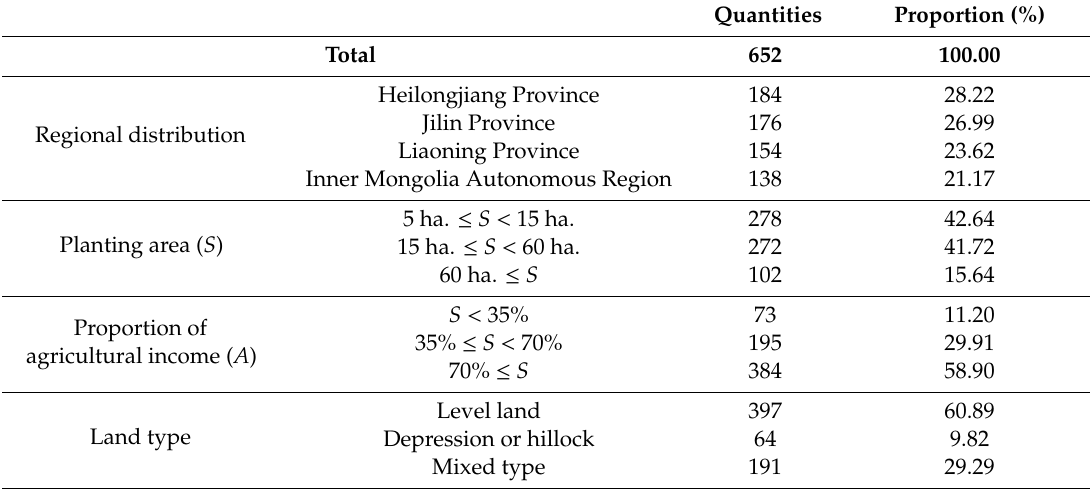
Table 3. Characteristics and distribution of 652